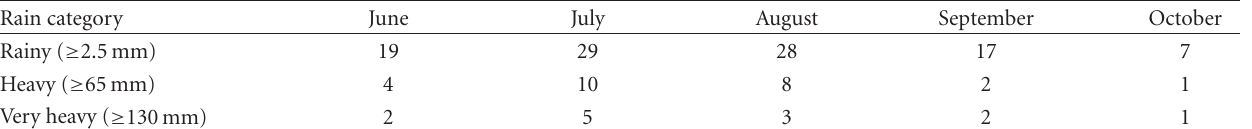
Table 5: Frequency of rainy days from June to October (1961–2005) over the Koyna catchment.